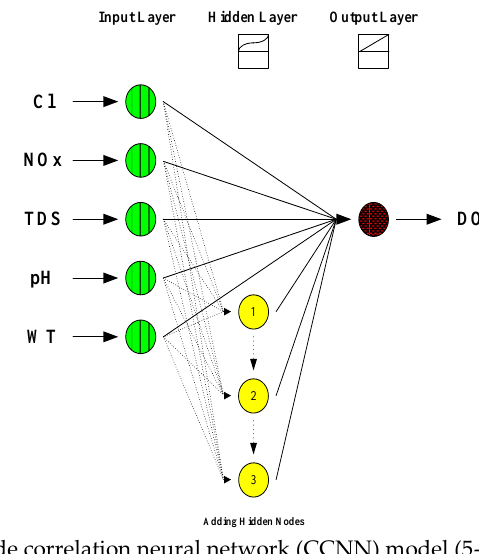
Figure 1. Structure of standalone soft computing models.